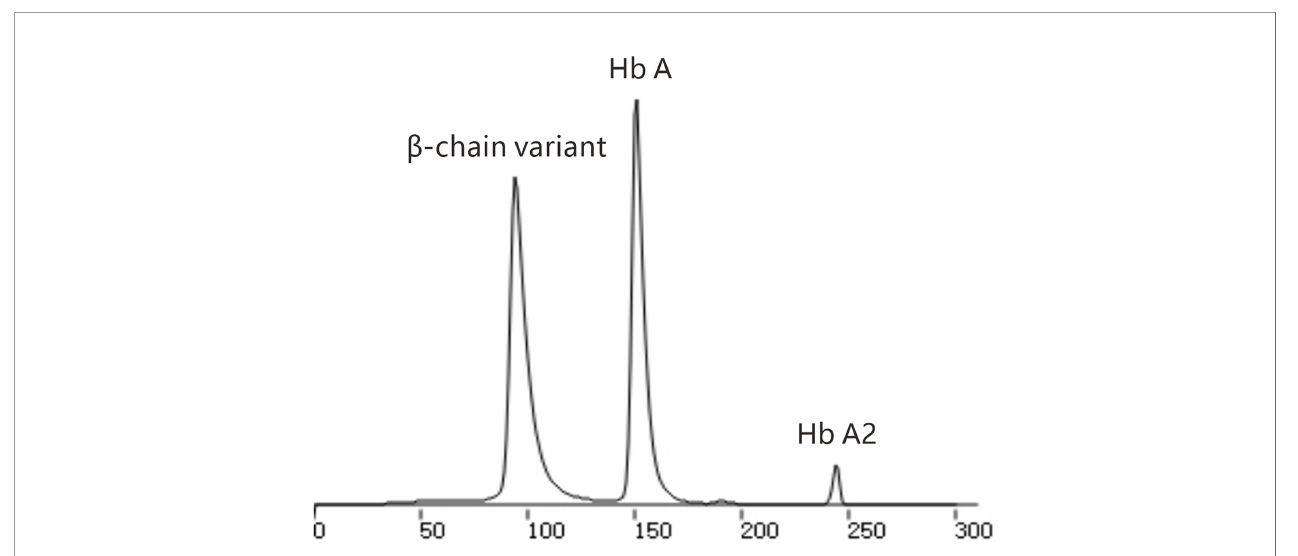
FIGURE 2 | Chromatography of hemoglobin electrophoresis.